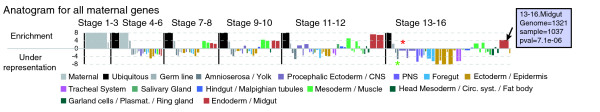
Normalized anatomical signature - the anatogram. A linear representation of the CV is used to show the enrichment of annotations within the set of all 3,334 maternally expressed genes versus the entire dataset of 4,759 genes expressed in the embryo. A vertical black line delimits stages, and each colored bar represents an individual CV term (an expanded color key is shown in Additional_data_fille 3). The width of each bar is proportional to the number of times a term was used in our entire dataset, and the height represents the relative enrichment of the given term within the particular gene set (in this case, all maternally expressed genes). Enrichment is given in units of standard deviation above or below the expected sample count based on the background frequencies (z-score). Terms with bars below the zero line are under-represented in the sample. The green asterisk corresponds to the 'amnioserosa' term, while the red asterisk corresponds to the 'brain' term. On the web supplement [21], the user can place the mouse pointer over any bar in the anatomical signature (arrow on the midgut bar in stage range 13-16) and obtain the gene count for the term in the entire dataset, the gene count within the particular set of genes under study, and a statistical p value of statistical over- or under-representation within the set (shown in the black bordered lavender box).